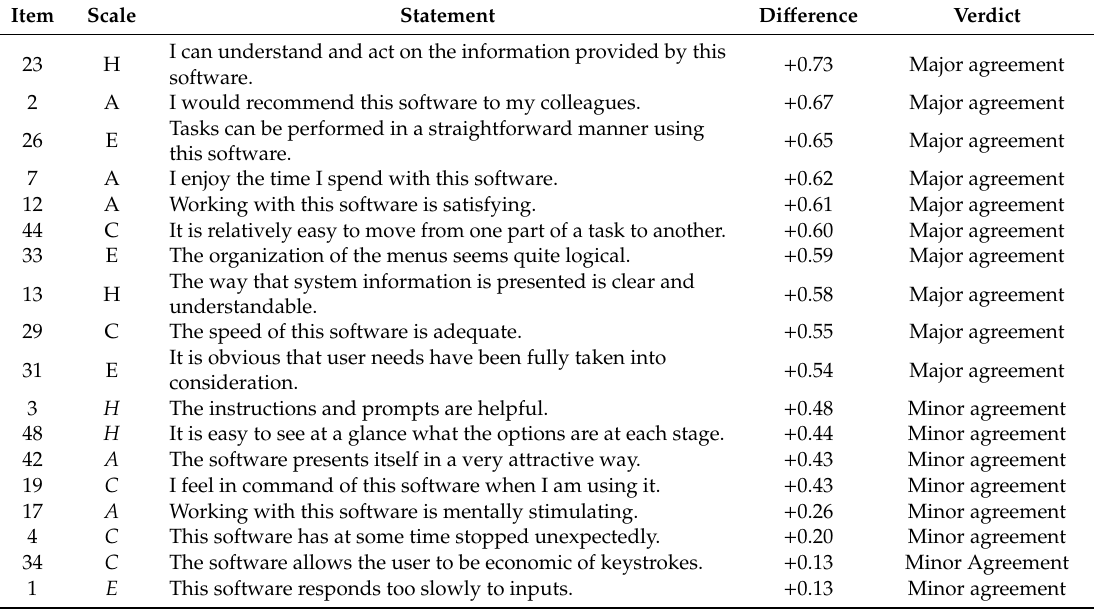
Table 3. Items indicating statistically significant results.